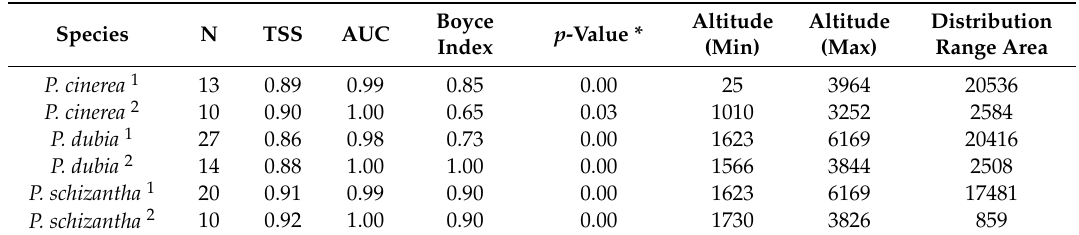
Table 1. Comparison between outcomes of species distribution model predictions for three species of the plant genus Phaedranassa